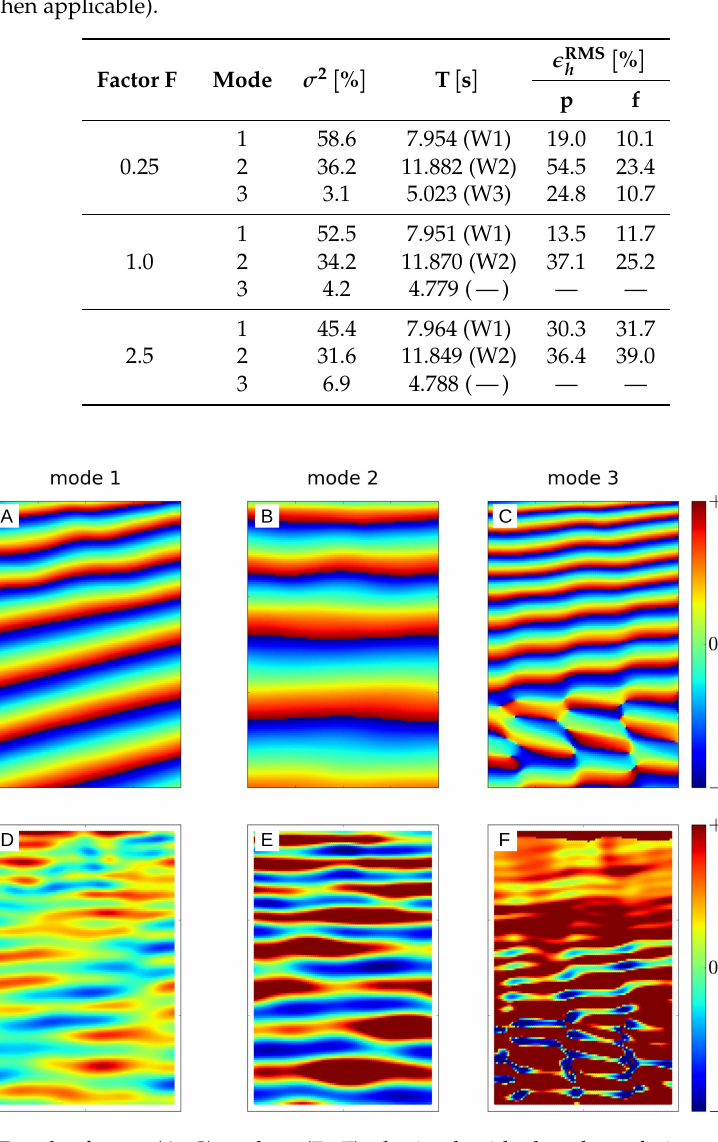
Figure 11. Results for α x ( A – C ) and (cid:101) h ( D – F ) obtained with the phase fitting method without windowing from the nonlinear polychromatic wave field WS with F = 1.0 for ∆ t = 0.532 s, ∆ x = 2 m, R t = 1.1 s, R x = 8 m, and t max = 90